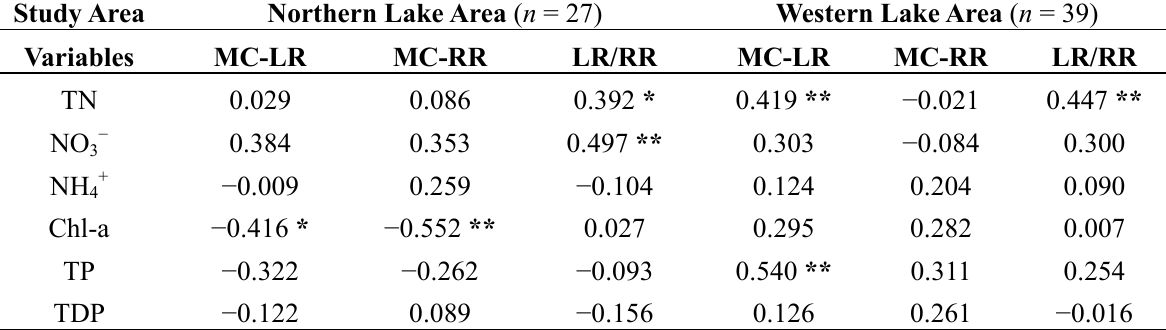
Table 1. Correlation coefficient between environmental variables in Lake Taihu (Pearson, 2-tailed, * for p < 0.05, significant; ** for p < 0.01, highly significant. LR/RR represents